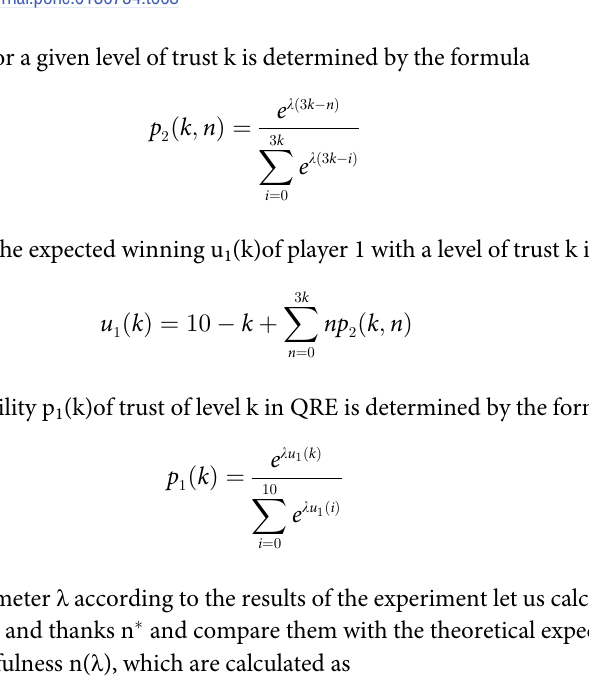
The table represents the average level of cooperation after